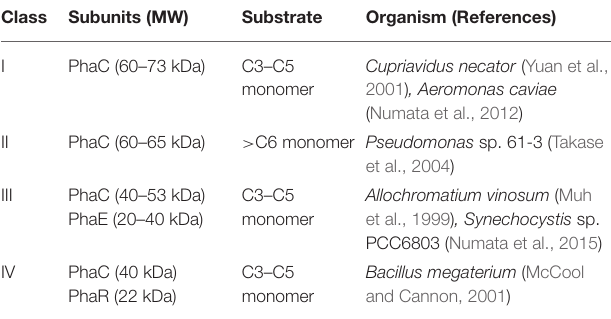
TABLE 1 | Classification of PHA